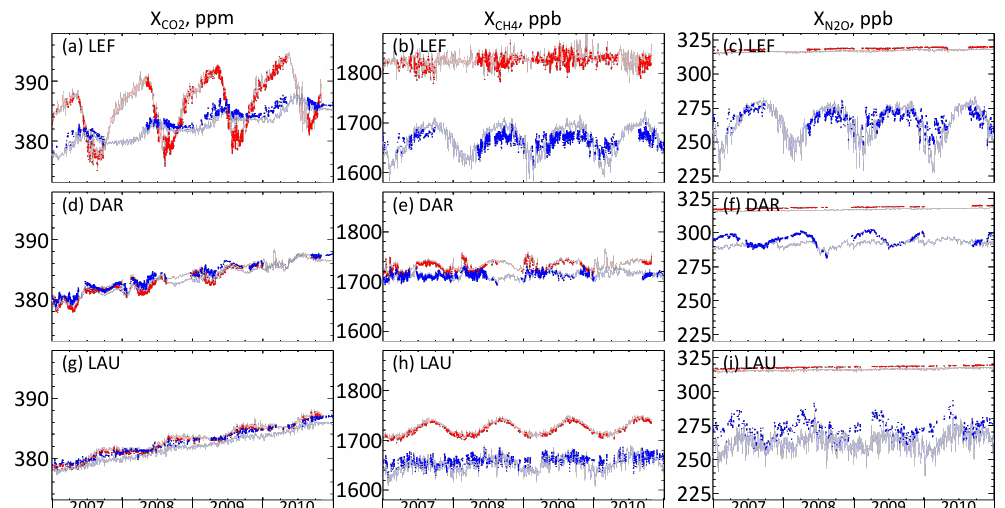
Fig. 6. Time series of ACTM partial columns in the troposphere (in red) and stratosphere (in blue) for CO 2 (left column), CH 4 (middle column) and N 2 O (right column) at three selected sites representing northern and southern midlatitudes and tropics. Continuous lines in lighter colours show the partial columns before smoothing by averaging kernels and a priori profiles. The tropospheric and stratospheric partial columns for monthly varying and annual mean tropopause are shown in Figs. S11 and S12.